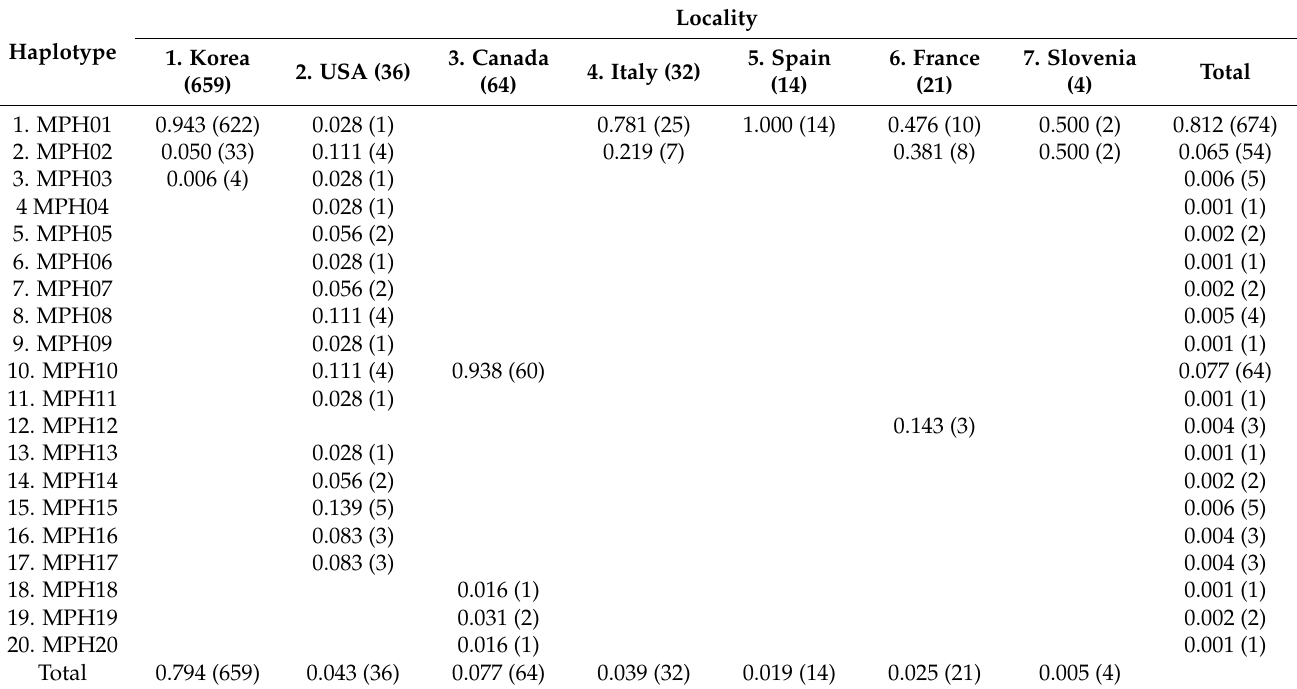
Table 1. Relative frequencies of worldwide mitochondrial COI haplotypes (470 bp) for 830 individuals of Metcalfa pruinosa obtained from the current study (536 individuals) and GenBank data (294 individuals).